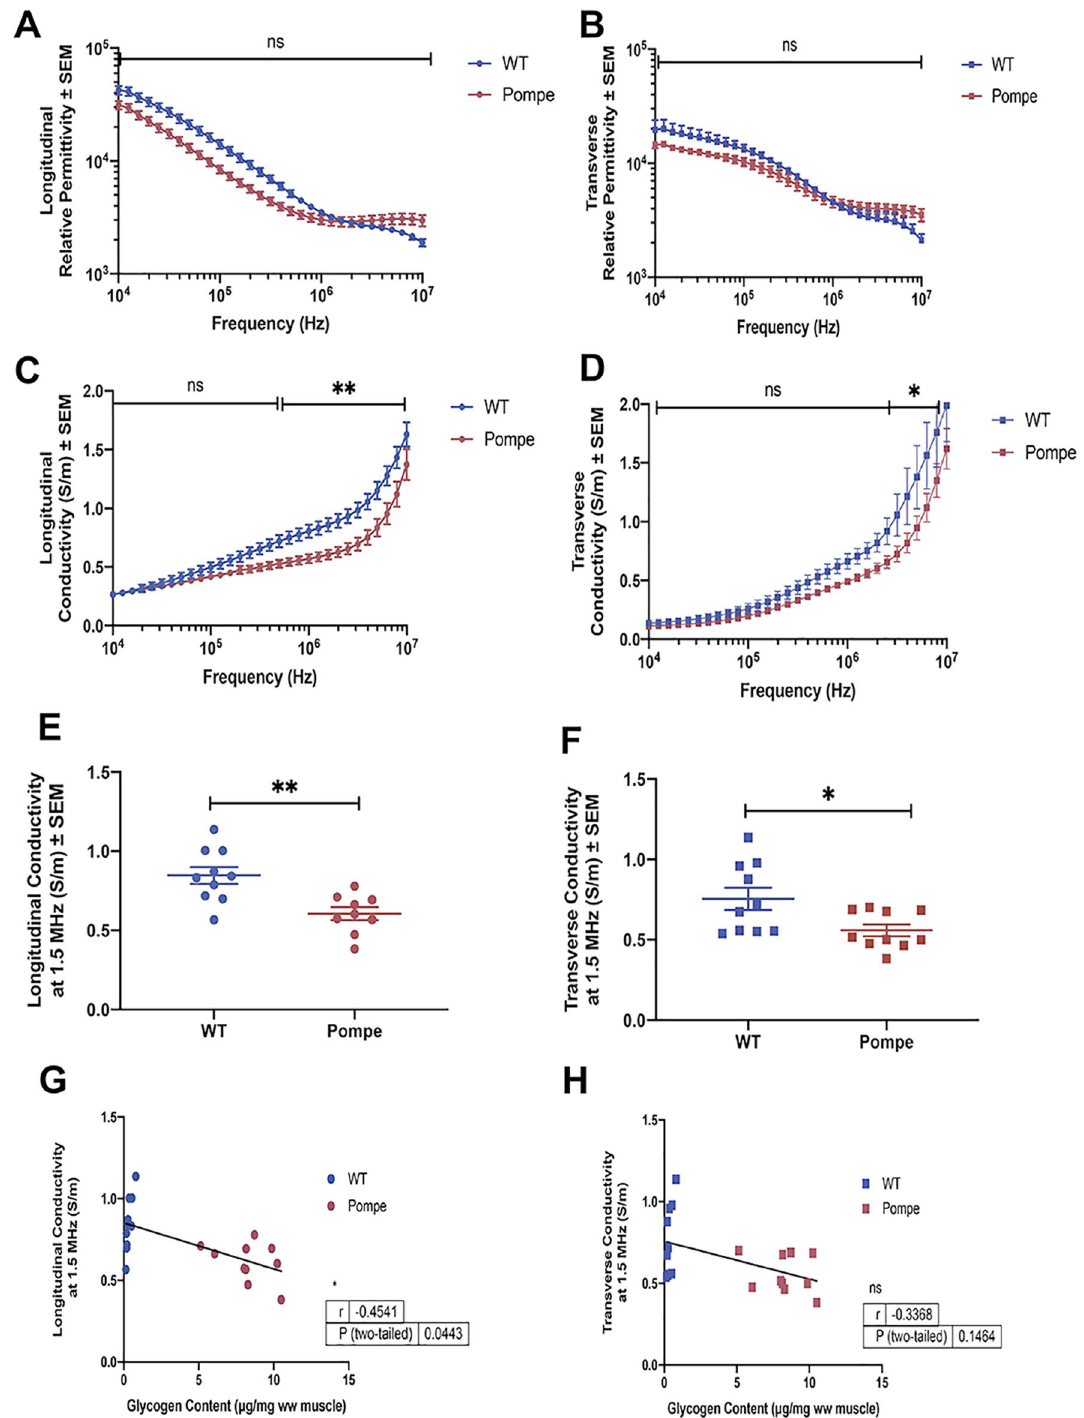
Figure 4. Dielectric properties of WT and Pompe gastrocnemius muscle. Relative permittivity values (mean ± SEM) from 10 kHz to 10 MHz in the longitudinal ( A ) and transverse ( B ) directions for WT and Pompe gastrocnemius (GA) muscle at 30 weeks showing no significant differences at any frequency. Conductivity values (mean ± SEM) from 10 kHz to 10 MHz in the longitudinal ( C ) and transverse ( D ) directions for the (GA) muscle from WT and Pompe mice at 30 weeks showing significant differences at frequencies > 1 MHz. GA muscle conductivity values at 1.5 MHz are depicted in the longitudinal ( E ) and transverse ( F ) directions for WT and Pompe mice at 30 weeks together with the respective mean ± SEM. Scatter plots showing the correlations between the glycogen content (GC) per animal and the measured conductivity at 1.5 MHz in both longitudinal ( G ) and transverse ( H ) directions. (Ordinary two–way ANOVA with Sidek’s Multiple comparisons test): * p < 0.05; ** p < 0.01; *** p < 0.001; **** p < 0.0001; ns not